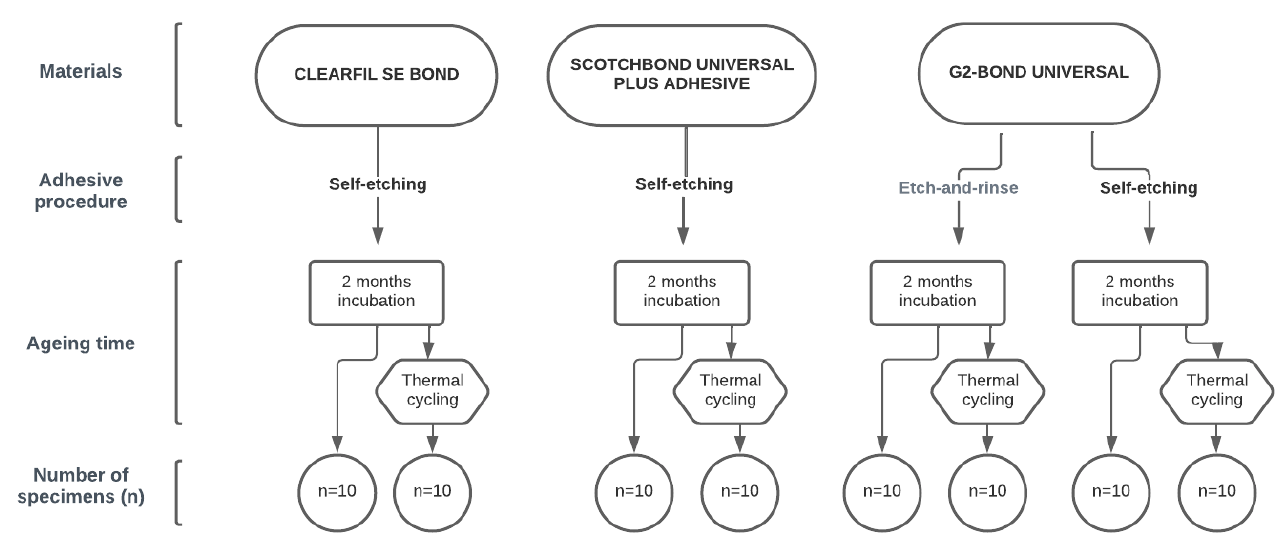
Figure 1. Samples’ Figure 1. Samples’ groups.